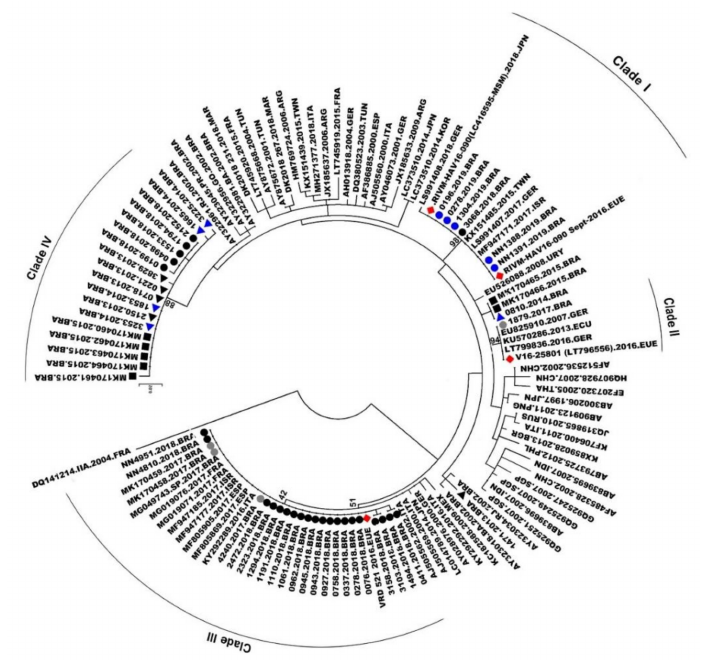
Figure 4. Phylogenetic tree generated using the Maximum Likelihood method with 3000-replicate bootstrap resampling, with 65 VP1-2A region reference sequences from genotype IA isolates from the GenBank. The number in the tree represents bootstraps. The viral European and Asian outbreak strains are marked with red rhombus ( (cid:7) ). The study sequences are marked with: 2013, black triangle ( (cid:78) ); 2014, blue triangle ( (cid:78) ); 2018, black dot ( • ); and 2019, blue dot ( • ). All study sequences